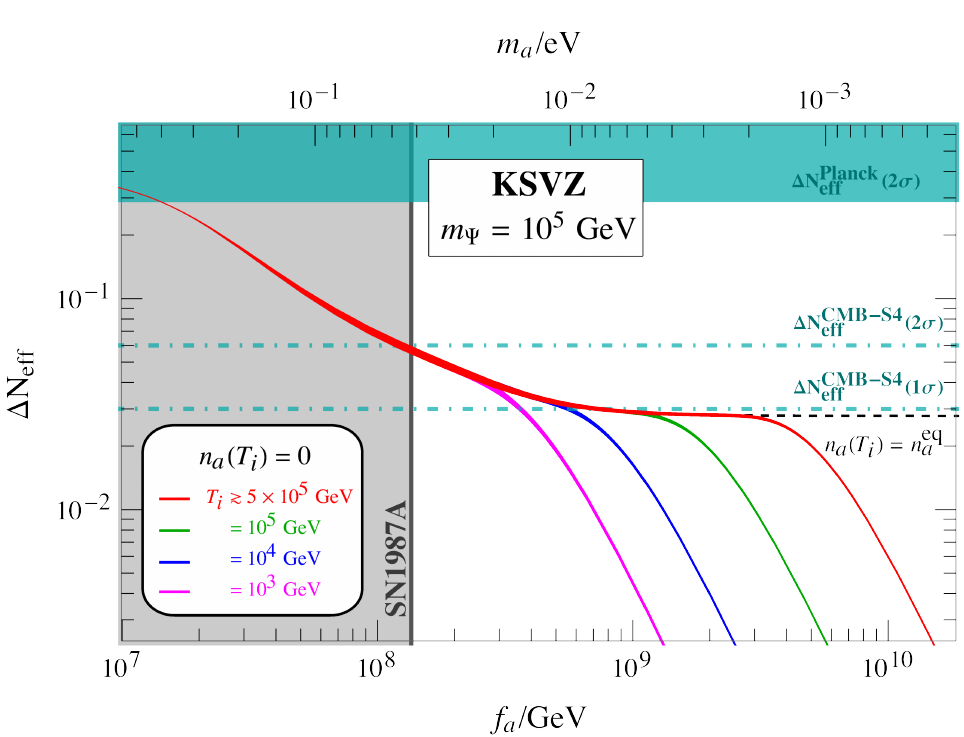
Figure 9 . Contribution to ∆ N eff as a function of the axion decay constant f a for the KSVZ axion.